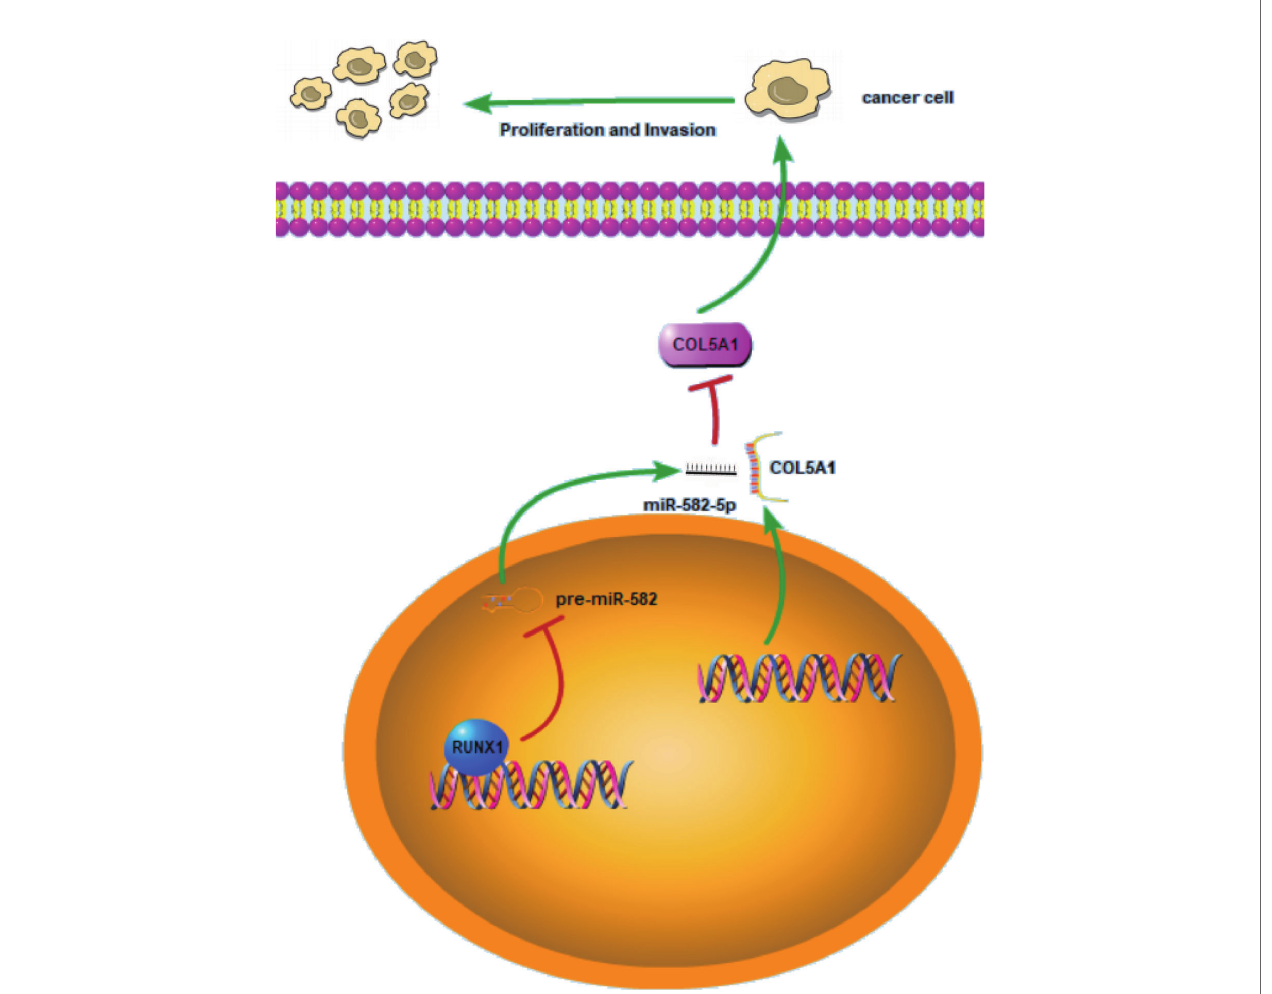
FIGURE 7 | Schematic diagram for miR-582-5p, mediated by RUNX1, regulates cell proliferation and invasion by targeting COL5A1 in ccRCC. RUNX1 was veri fi ed to bind to miR-582-5p promoter and attenuated miR-582-5p expression in ccRCC. miR-582-5p regulated cell proliferation and invasion in ccRCC by targeting COL5A1. The experiments were repeated three times with similar